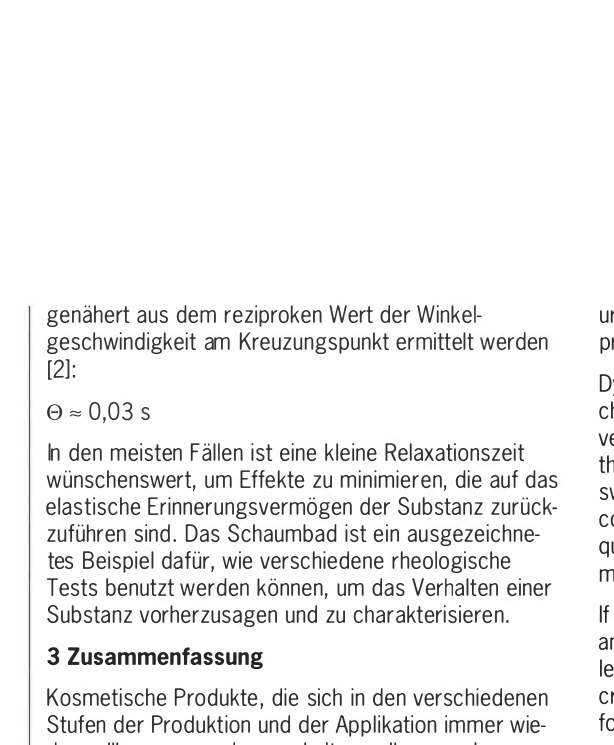
Abb. 8: Untersuchung einer Schaumbadprobe in einem Oszillationsversuch Fig. 8: Frequency sweep of the bath